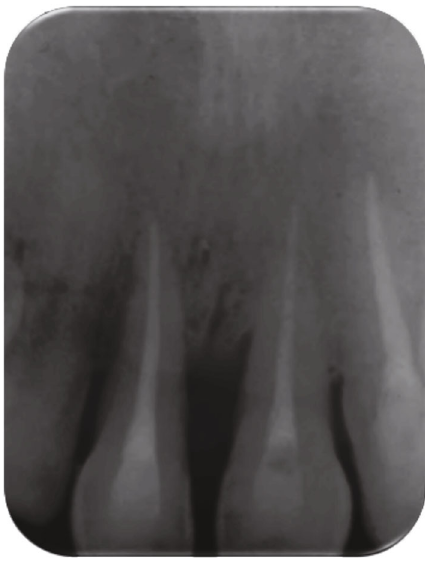
Figure 6: Obturation canals after 3-months medication with replanted calcium hydroxide